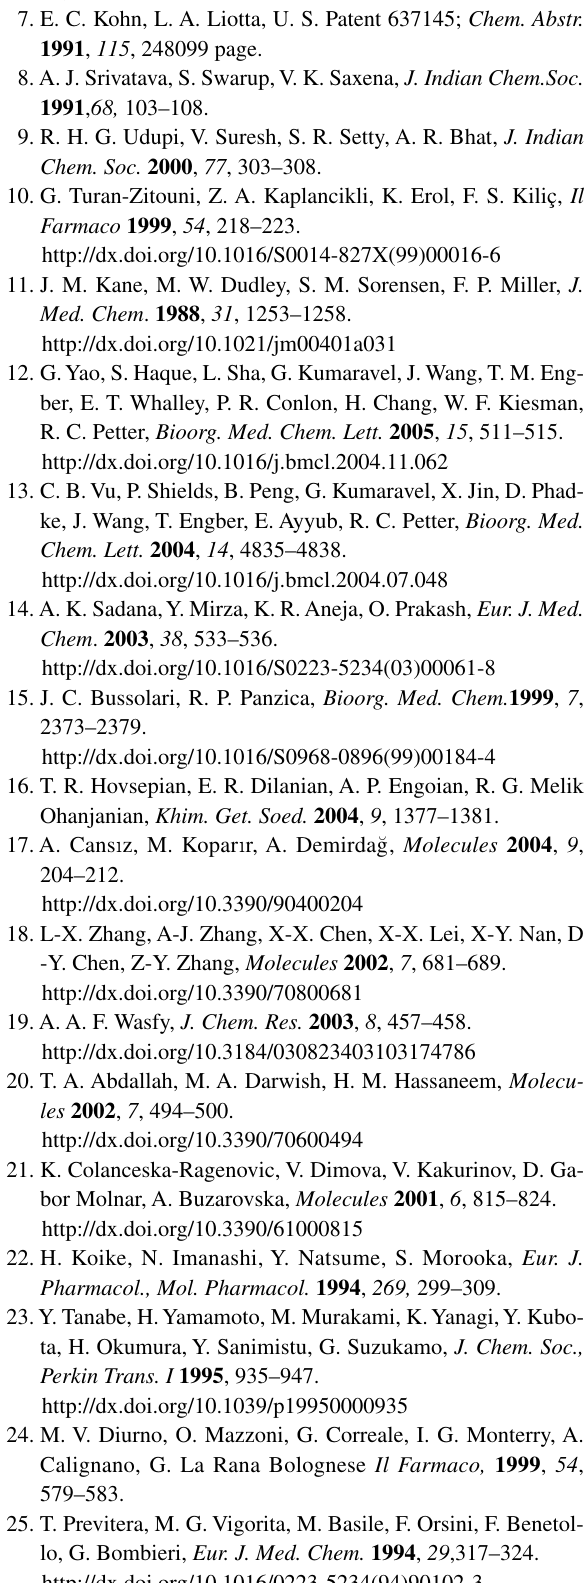
Table 2. Antifungal activity of 5a – e and 6a – e